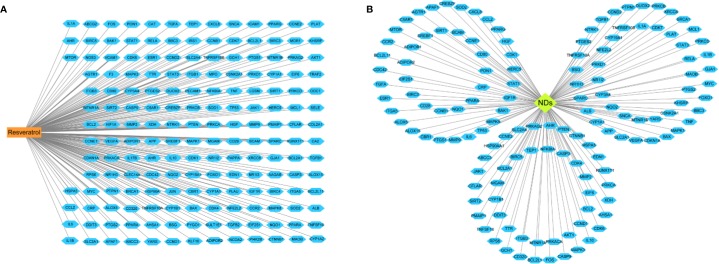
Linkage of drug, disease, and target genes. (A) The network of resveratrol- candidate targets. (B) Network of 138 common potential protein targets related to neurodegenerative diseases (NDs). The orange rectangle represents the resveratrol, green diamond means NDs and blue hexagon represent the target genes on which the drug acts.